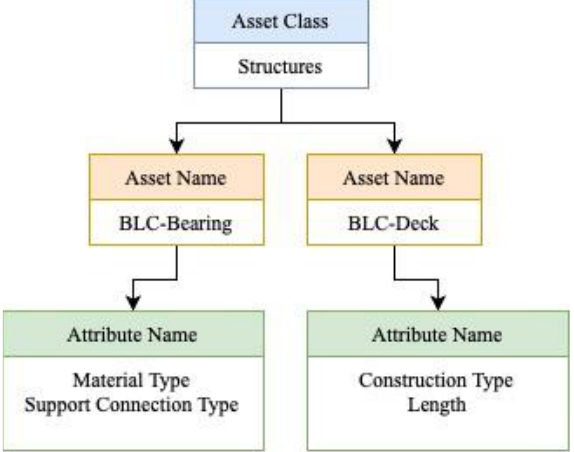
Figure 2 . UML Representation of the ADMM-An example.